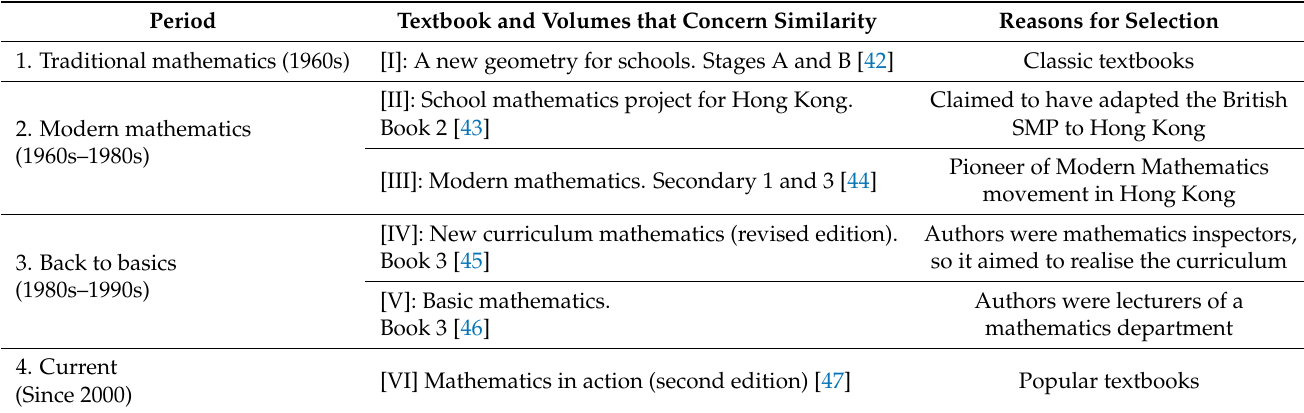
Table 1. Textbooks selected for